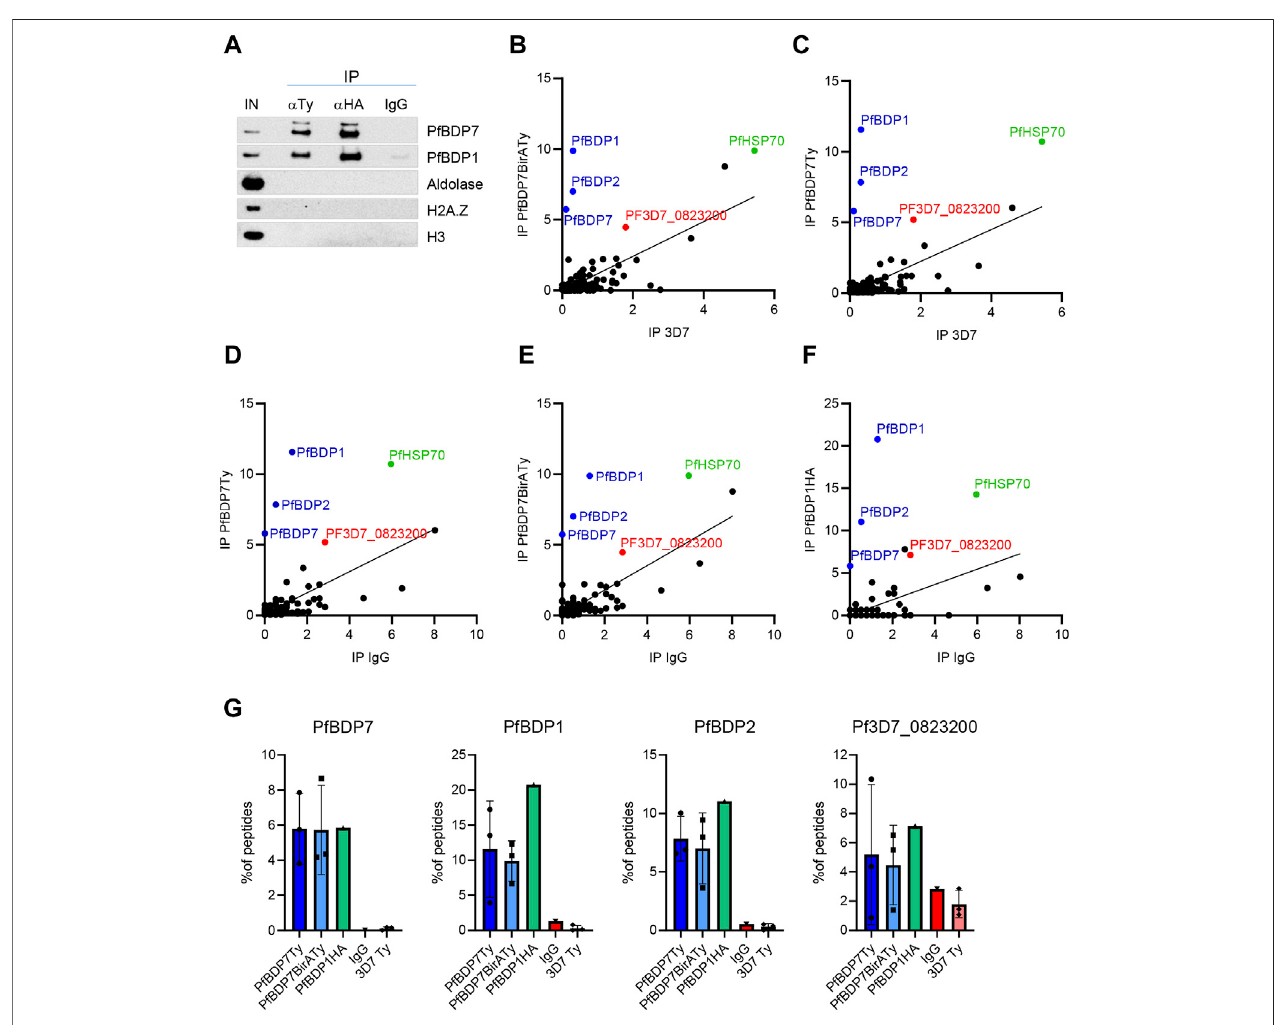
FIGURE3| Identi fi cationofPfBDP7interactionpartners. (A) Co-ImmunoprecipitationofPfBDP7BirATyandPfBDP1HAfromPfBDP1HA::PfBDP7BirATyparasites demonstrates that the two proteins are part of the same protein complex. The immunoprecipitation (IP) from micrococcal nuclease treated chromatin (input, IN) was performed with mouse anti-Ty, rat anti-HA or IgG antibodies as negative control. (B – F) PfBDP7 or PfBDP1 associated proteins were isolated by Co-IP and identi fi ed by Mass Spectrometry. Enrichment of peptides was calculated as % peptide counts of all peptides identi fi ed in each IP, biological replicates were averaged ( N = 1-3, see SupplementaryTableS3 )andplottedagainstthenegativecontrols.IP3D7:anti-TyIPin3D7wtparasites,IPIgG:non-immuneIgGonPfBDP7Ty_GlmSparasites. (G) Enrichment of PfBDP7, PfBDP1, PfBDP2 and Pf3D7_0823200 peptides from individual IPs.